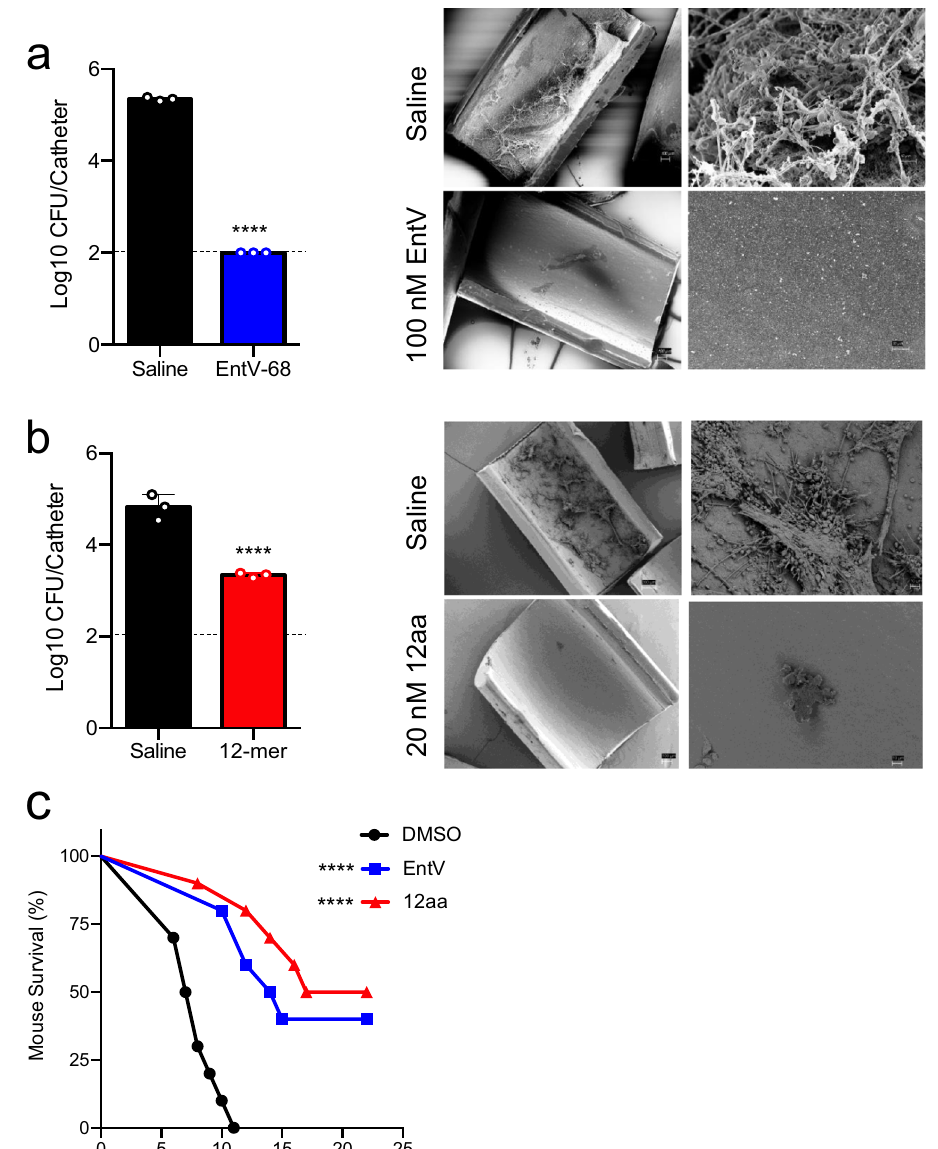
Fig. 6 | The 12mer is protective in models of venous catheter and systemic C. albicans infection. In a , b , intravenous catheters were implanted into the jugular veinsofratsandinoculatedwith C.albicans withorwithoutEntVpeptidesusingan nofthreebiologicallyindependentanimals.After24hthecatheterswereremoved and CFUs were determined from one-half (left panels) and scanning electron micrographs were taken at 100x (left) or 1000x (right) of the other half of the catheters (right panels) with a showing treatment with EntV at 100nM and b showing treatment with the 12mer at 20nM. The dashed lines are the detection